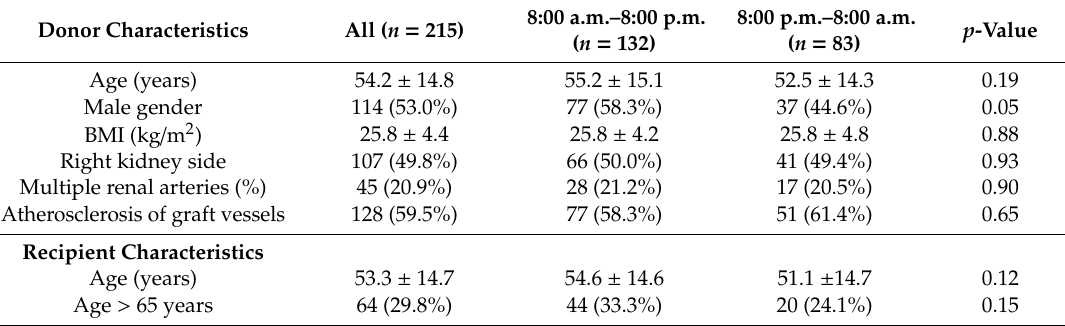
Table 1. Recipient and donor characteristics and operative details. Results are presented as mean and standard deviations or as absolute and relative frequencies; h—hours; min—minutes; ESRD—end-stage renal disease; * statistically